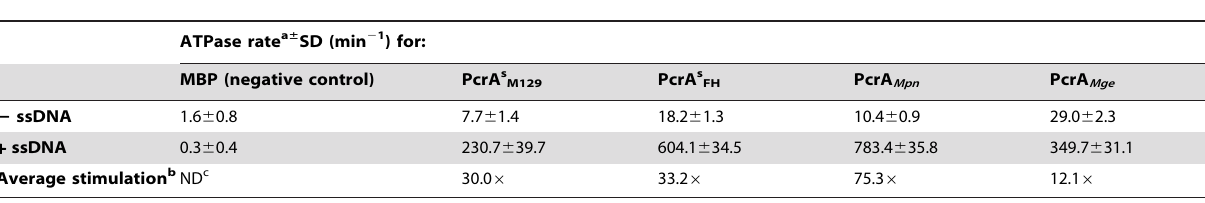
ATPase rate a ± SD (min 2 1 )